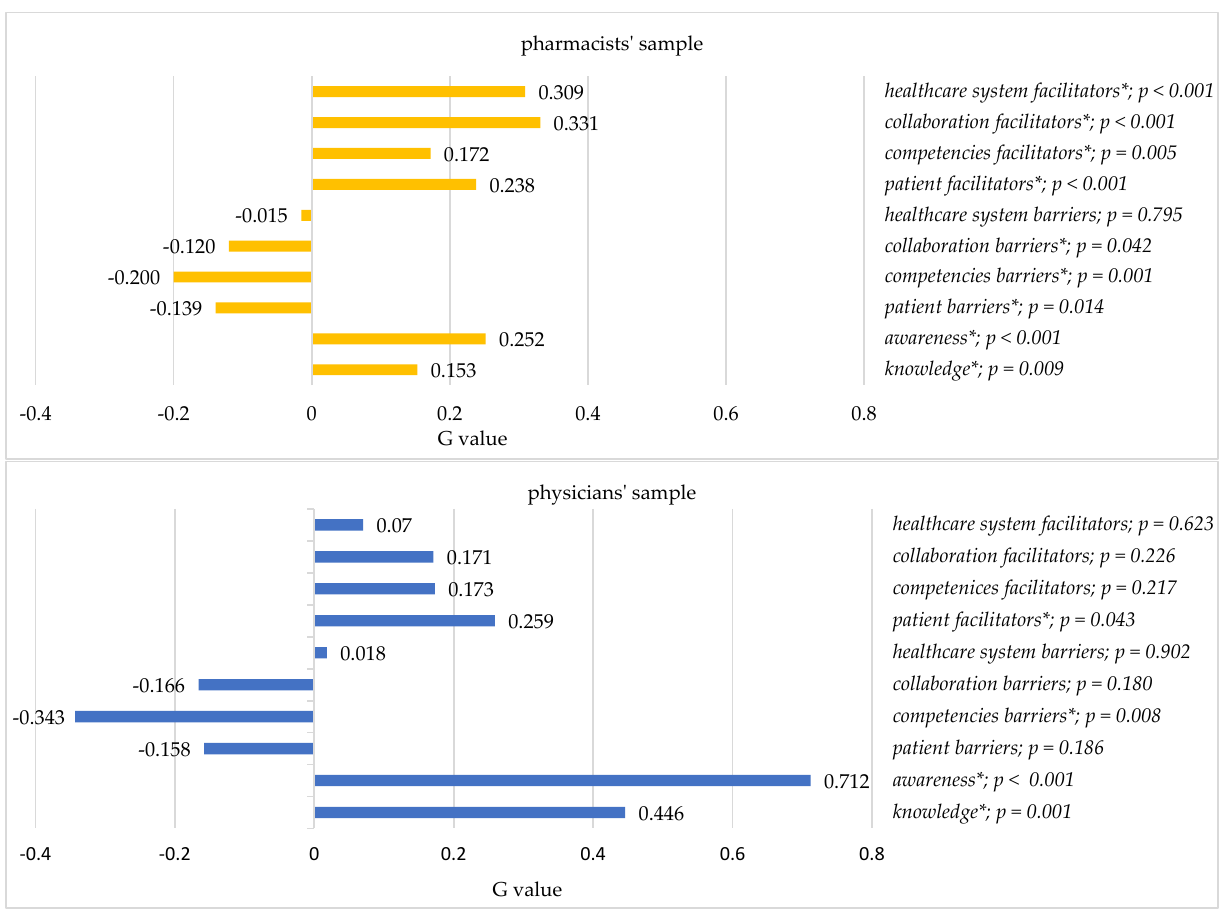
Figure 2. Gamma rank correlation